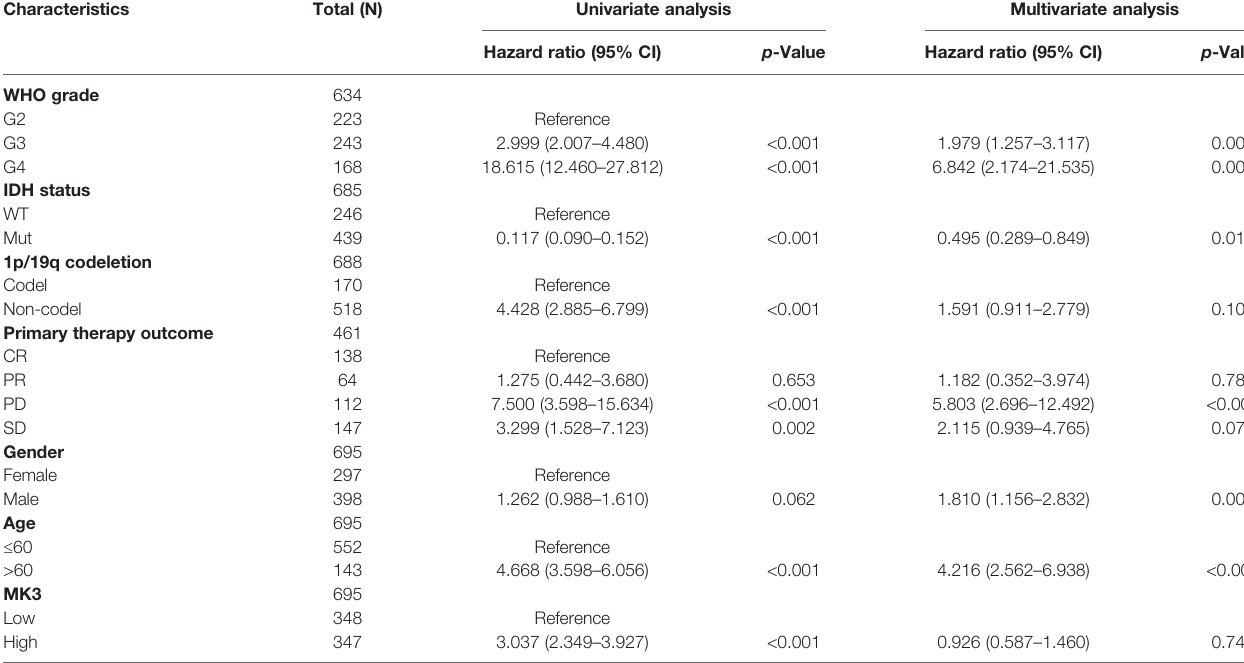
TABLE 3 | Univariate and multivariate Cox proportional hazards analyses of MK3 expression and overall survival for glioma patients.